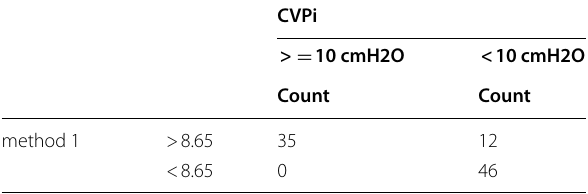
Table 6 For the classification by the cut‑off value in method 2